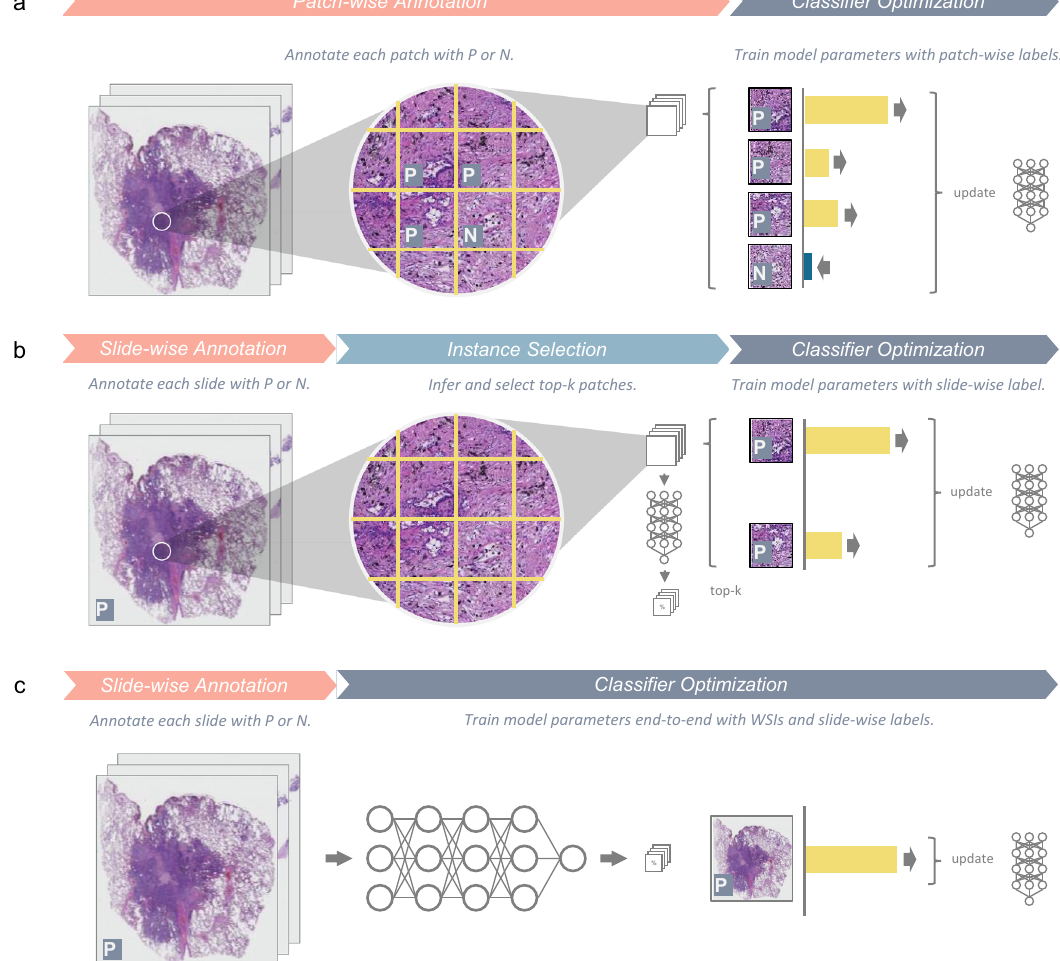
Fig. 7 Work fl ow overview of the traditional patch-based method, MIL method, and our proposed whole-slide training method. a Patch-based method requires a substantial number of patch-level annotations by human experts. Given pairs of a patch image and its corresponding label in manually annotated regions, a deep neural network is trained in a strong supervision manner. b MIL leverages slide-level annotations by exhaustive inferences patches and paired the top-k patches most likely to be cancerous to their slide-level tags. These weakly paired patches and temporary tags are then used to update a neural network. c Our proposed whole-slide training method feeds an entire slide image with its corresponding slide-level tag into a neural network to ful fi ll end-to-end slide-level training in a strong supervision